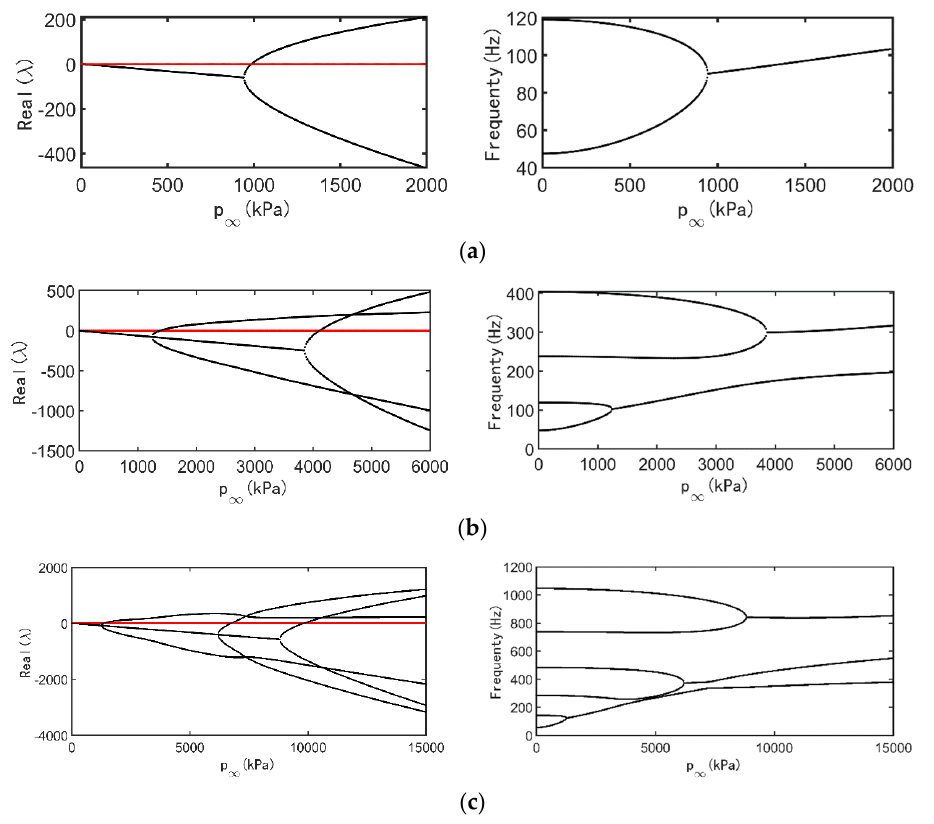
Figure 5. The curves of eigenvalue with the flow pressure change. (a) M = 2, (b) M = 4, (c) M = 6. Figure 6 gives the waveform and phase diagrams of the plate under different airflows.